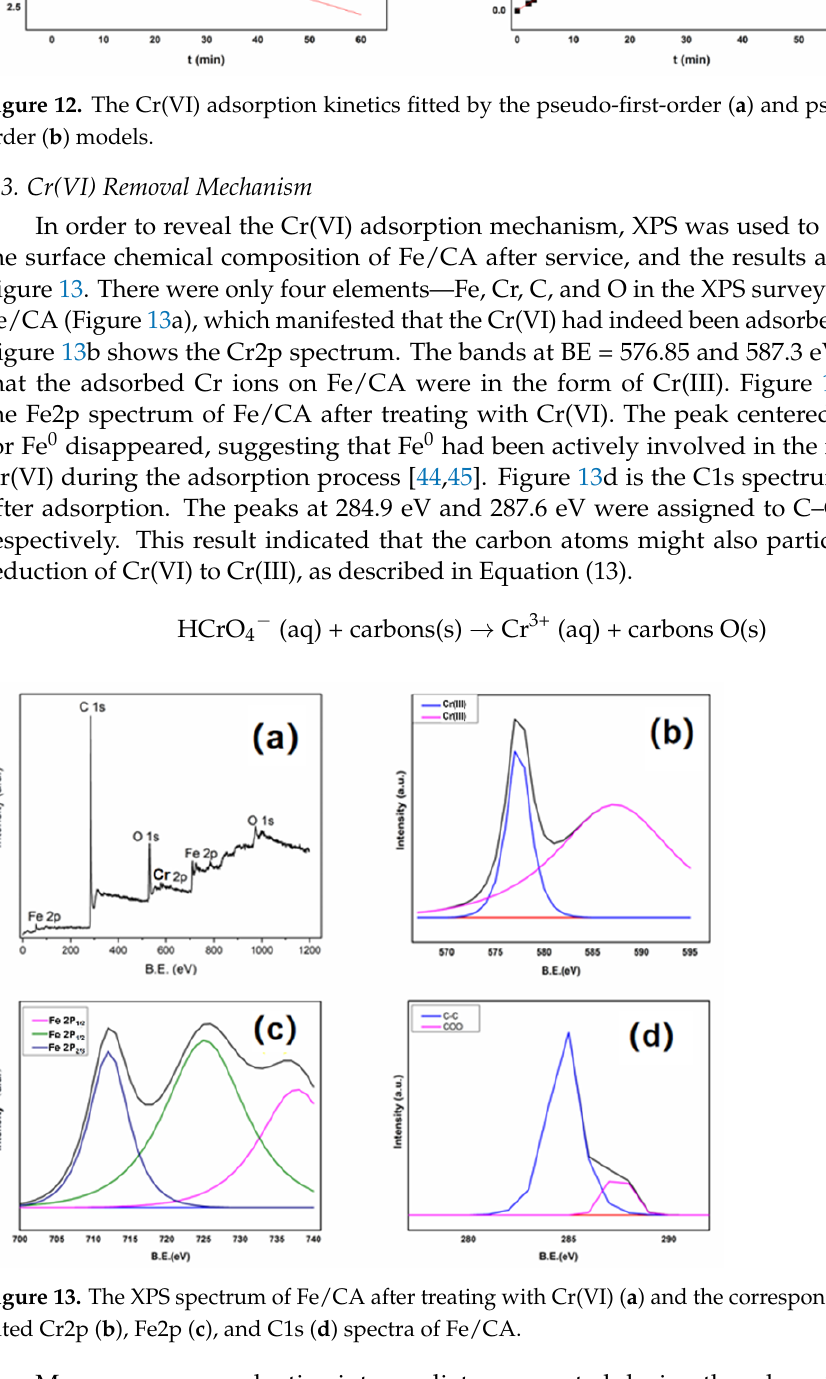
Figure 12. The Cr(VI) adsorption kinetics fitted by the pseudo-first-order ( a ) and pseudo-second- order ( b ) models.